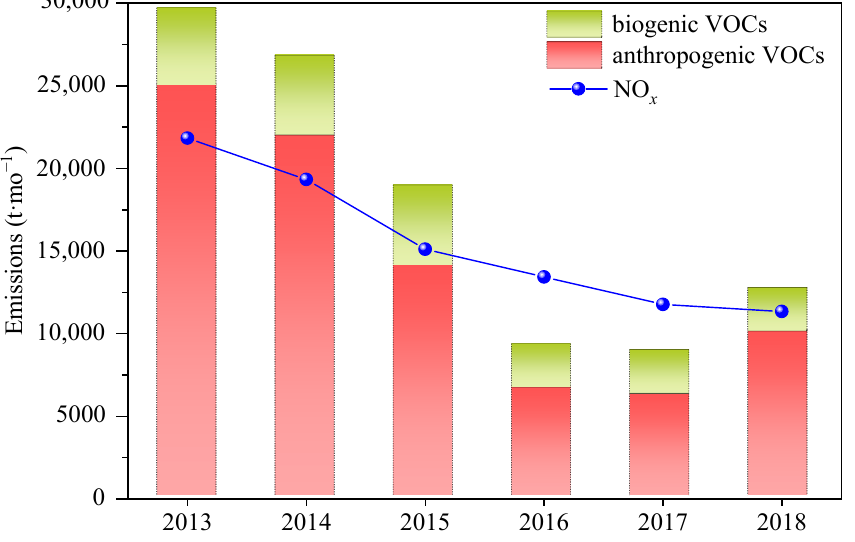
Figure 4. Changes in emissions of volatile organic compounds (VOCs) and NO x in Handan during June of 2013–2018.